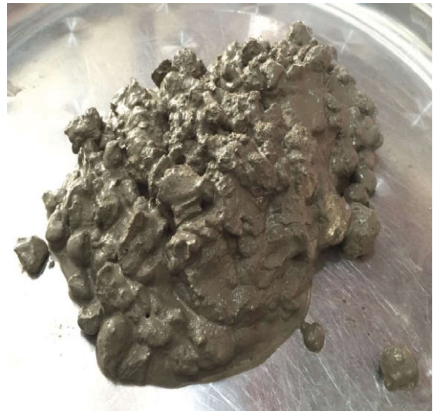
Figure 6: The directionally distributed steel